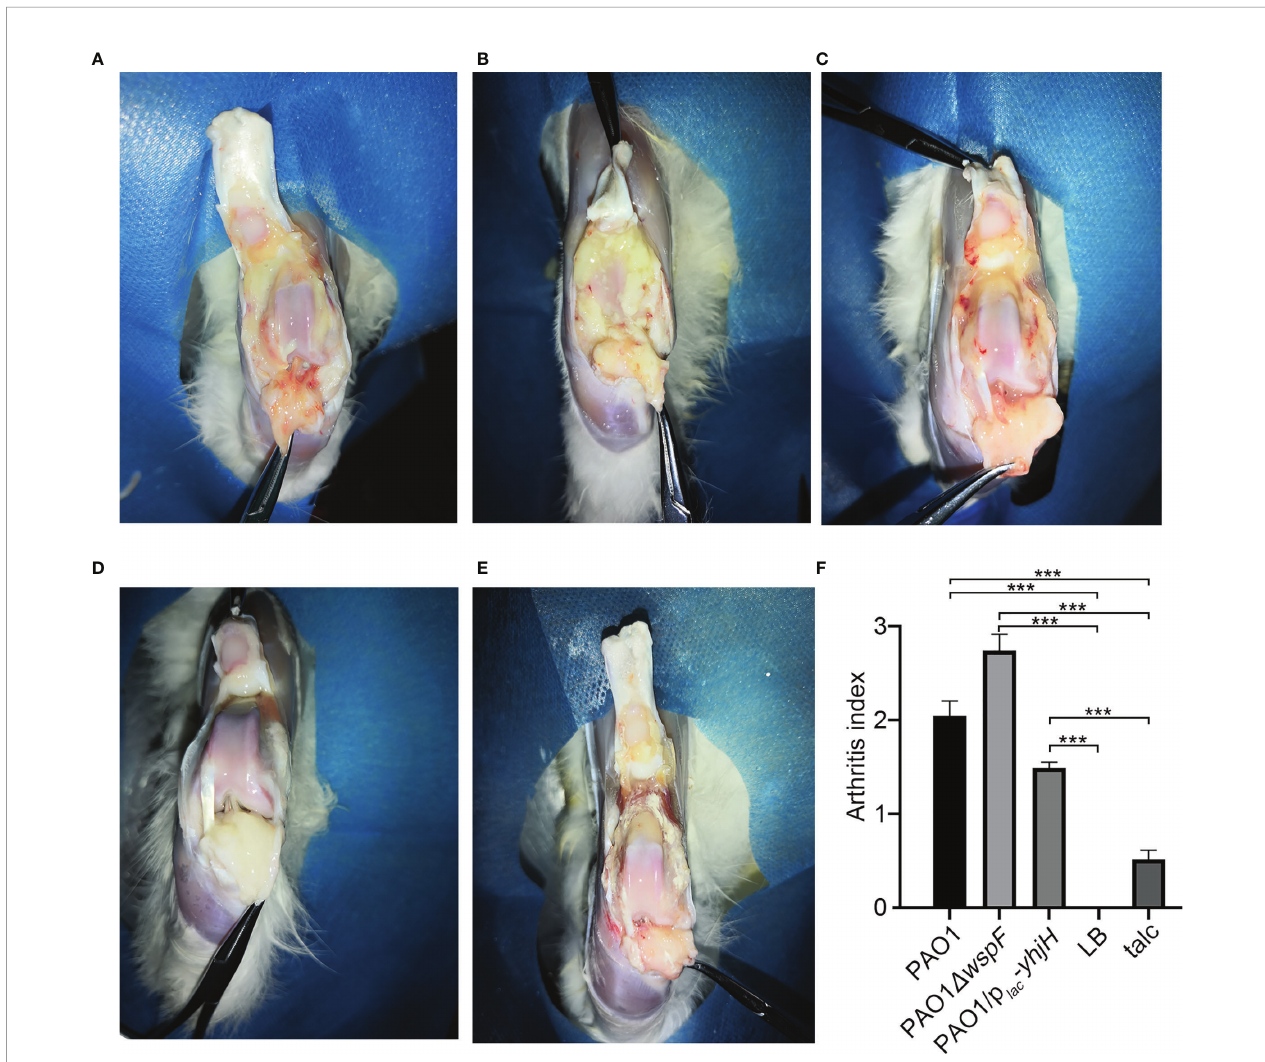
FIGURE 1 | The gross pathology specimens of rabbit joint cavities 7 days after inoculation. (A) PAO1 group. (B) PAO1 D wspF group. (C) PAO1/p lac -yhjH group. Varying degrees of joint adhesion and fi brin depositions between the joint cavity and synovial membrane in the abovementioned groups. (D) In the LB control group, there were no signi fi cant changes in the right joint cavity. (E) In the talc control group, there was severe aseptic in fl ammation. (F) The arthritis index of each group. Results are represented as the mean ± SD. *** p < 0.001 versus LB and talc control groups (control group). ANOVA test was used to compare group differences (600 × 600 DPI). LB, Luria – Bertani; talc, magnesium